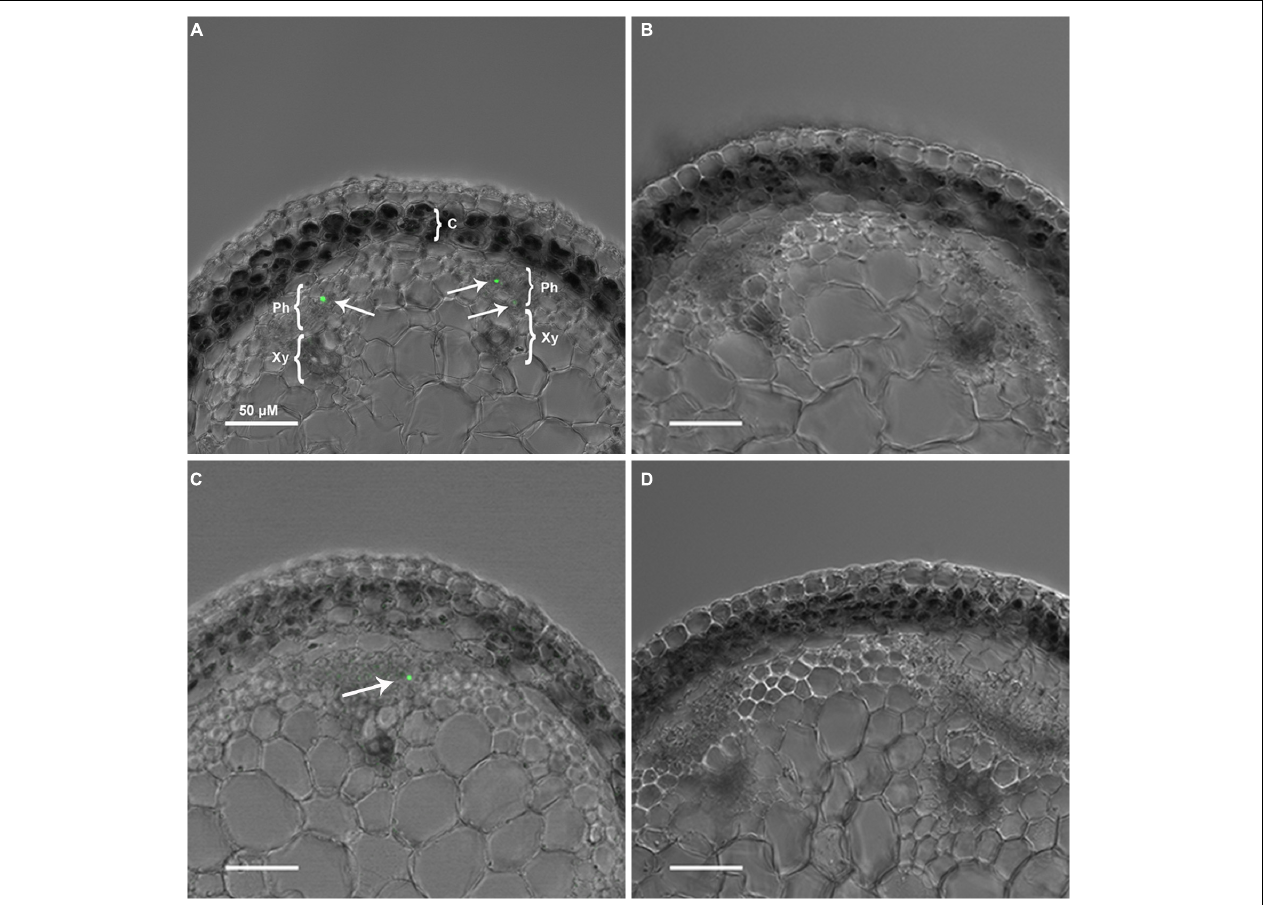
FIGURE 3 | OGA 488 labeling of P-proteins (arrows) in Arabidopsis thaliana ecotypes. (A) Col-0-WT labeled with OGA 488 . C, cortex; Ph, phloem; X, xylem, scale bar = 50 µ m. (B) Col-0-WT with no probe (control). (C) GABI-KAT- 609F04 labeled with OGA 488 . (D) SALK 148614C labeled with OGA 488 . A minimum of three plants of each genotype was sectioned, and at least six sections probed and imaged. Number of labeled cells within individual vascular bundles: Col-0-WT mean 1.2, SE 0.1; GABI-KAT- 609F04 mean 1.1, SE 0.1; SALK 148614C mean 0, SE